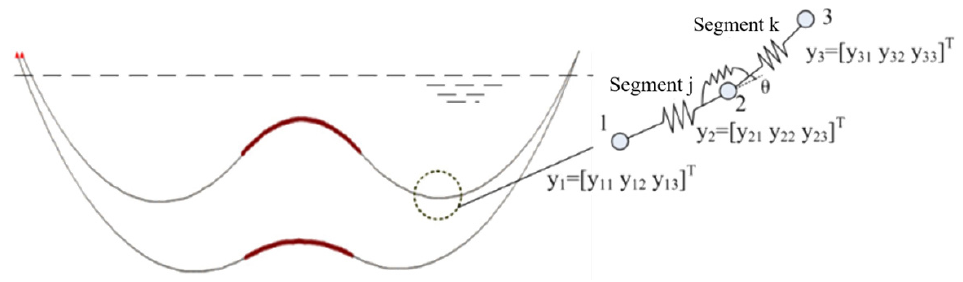
Figure 5. Schematic diagram of line segments in lumped mass model.